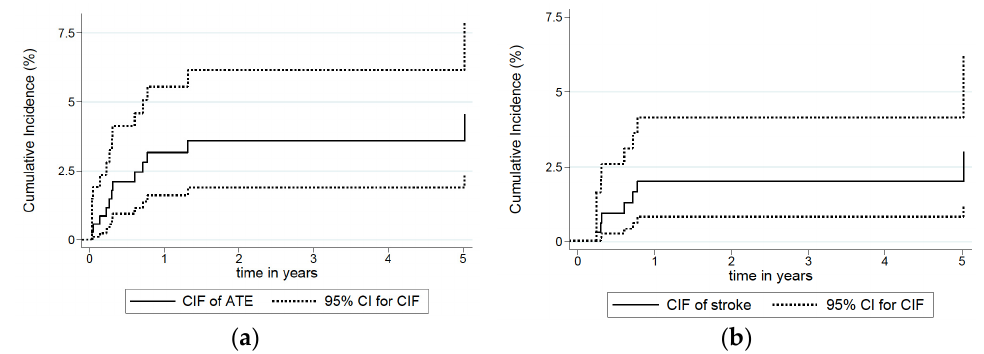
Figure 1. Cumulative incidence function (CIF) of all arterial thromboembolic events (ATEs) ( a ) and specifically for ischaemic strokes ( b ) over time from the initiation of first-line chemotherapy, with death as competing risk, for 354 patients treated for advanced urinary tract cancer. CI: confidence interval. Table 2. Arterial thromboembolic (ATE) risk in 354 patients with advanced urinary tract cancer receiving first-line chemotherapy. Ι ncidence function was calculated with death as a competing risk. The 95% confidence intervals are shown in parentheses.